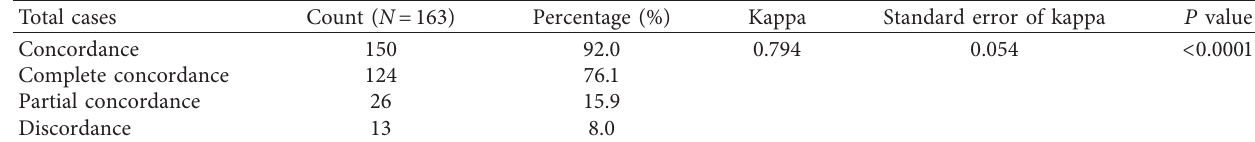
Table 1: Correlation of peripheral blood NGS and bone marrow NGS.